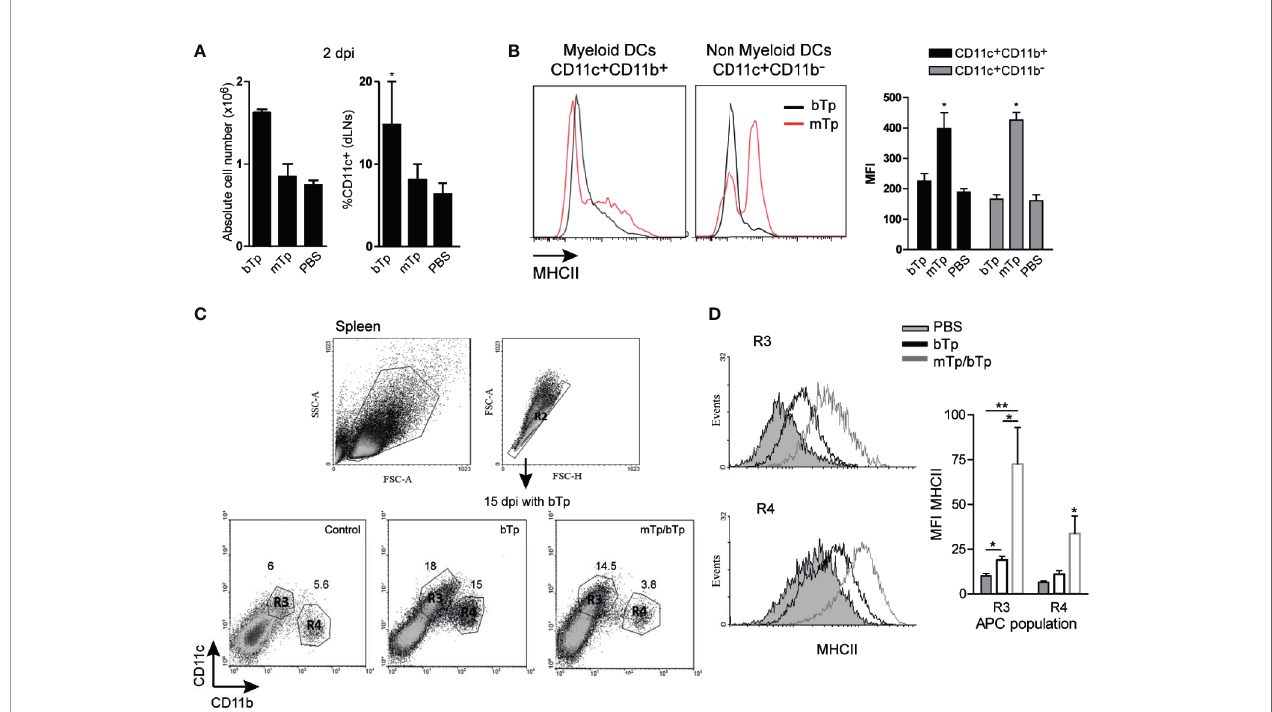
FIGURE 3 | Analysis of DC populations from draining lymph nodes (dLNs) and spleen in mTp- and bTp-infected mice by fl ow cytometry. (A) Absolute cell number in dLNs (submandibular LN) expressed as the mean + SEM of three independent experiments (left) and percentage of DC population in total cells from dLNs (right). *p < 0.05 (one-way ANOVA and Dunnett ’ s post-test). (B) MHCII expression on myeloid and non-myeloid CD11c + cells from animals infected with mTp (red line) or bTp (black line) in dLNs at 2 dpi (left). Mean fl uorescence intensity (MFI) of MHCII expressed in myeloid and non-myeloid CD11c + cells represented as the mean + SEM (right). Data are representative of three independent experiments (three biological replicates with duplicates per condition). *p < 0.05 (one-way ANOVA and Bonferroni ’ s post-test). (C) Gating strategy for the selection of myeloid and non-myeloid populations (CD11c + CD11b + , CD11c + CD11b low/neg , R1 – 4) in the spleen at 15 dpi. Data are representative of three independent experiments (three biological replicates with duplicates per treatment) with similar results. (D) MHCII expression in R3 and R4 populations. The gray histogram corresponds to NI samples, the gray line corresponds to the mTp, and the black line to samples from mTp-infected mice and challenged with bTp (left). Mean fl uorescence intensity (MFI) of MHCII expressed in myeloid (R4) and non-myeloid (R3) populations represented as the mean + SEM (right). *p < 0.05, **p < 0.01 ( N = 3 with duplicates as expressed above, one-way ANOVA and Bonferroni ’ s